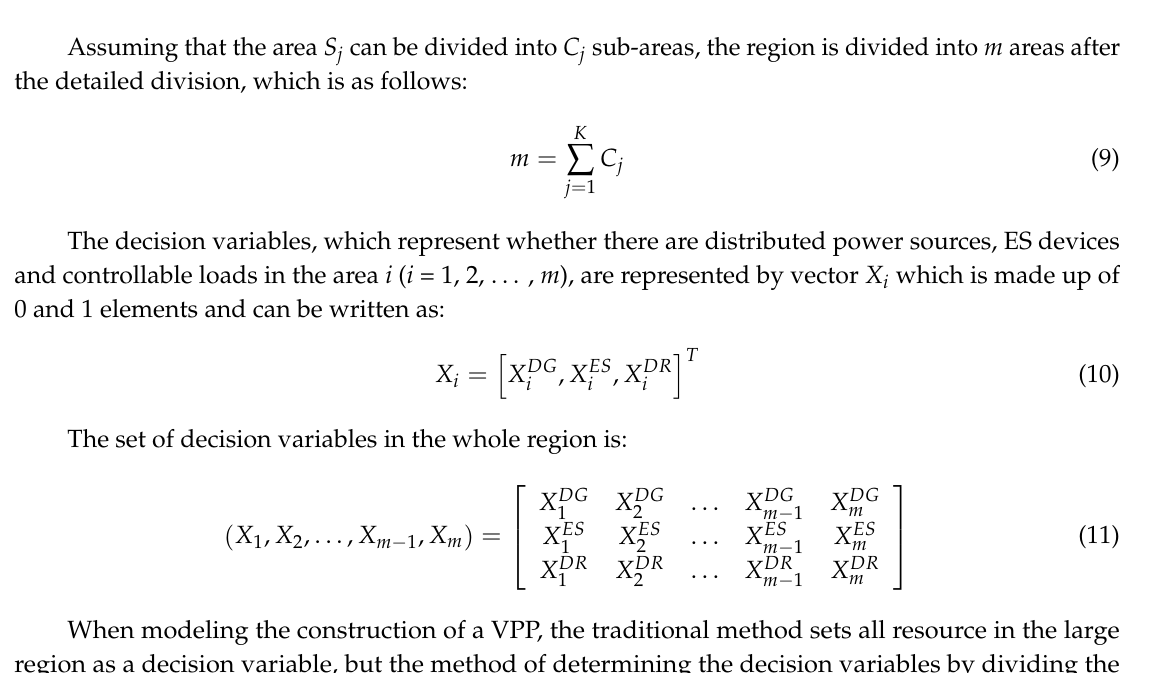
Figure 4. Detailed division of decision area of VPP.